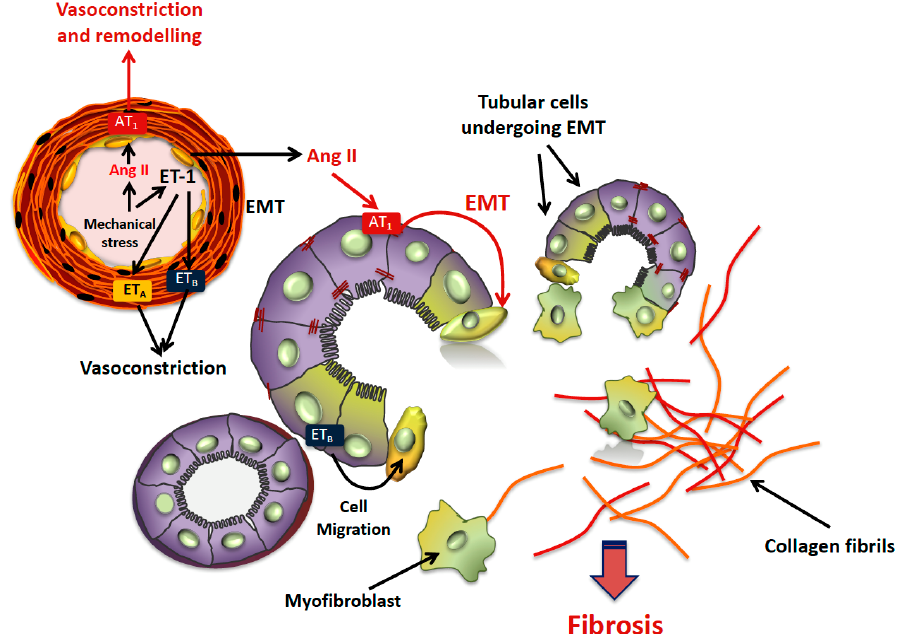
Figure 1. Development of tubule-interstitial damage in the hypertensive disease. When angiotensin II and / or endothelin-1 are abnormally produced, such as under conditions characterized by excess mechanical or oxidative stress, epithelial-to-mesenchymal transition (EMT) is triggered, leading to transformation of tubular cells into myofibroblasts that produce collagens. The final event is tubulo-interstitial fibrosis. Angiotensin II (Ang II), by binding Ang II type 1 (AT1) receptors in the vascular smooth muscle cells, also favors vasoconstriction and vascular remodeling, worsening kidney damage. Vasoconstriction is also mediated by endothelin-1 via ET A and ET B receptors, located at the vascular smooth muscle cells.